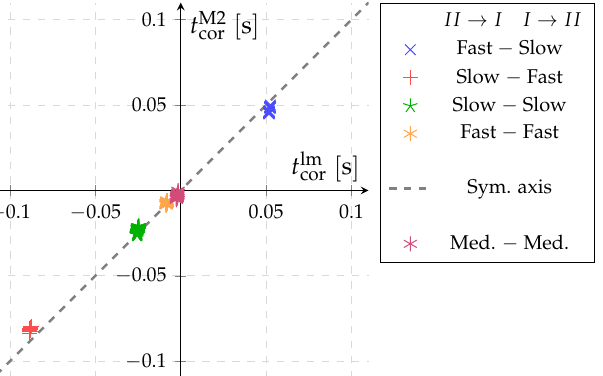
Figure 10. Comparison of the measurement results for the correction time according to Method 2 and the approximation model Equation (9) ( q m ≈ 9 mgmin − 1 ).